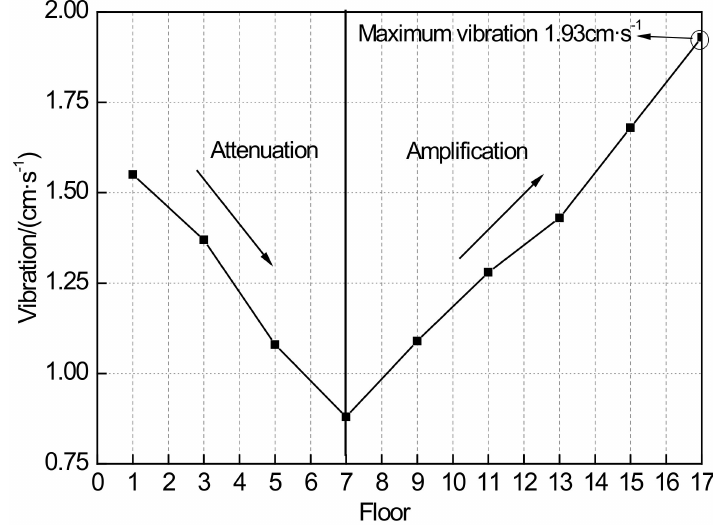
Figure 8. PPV variation on the di ff erent